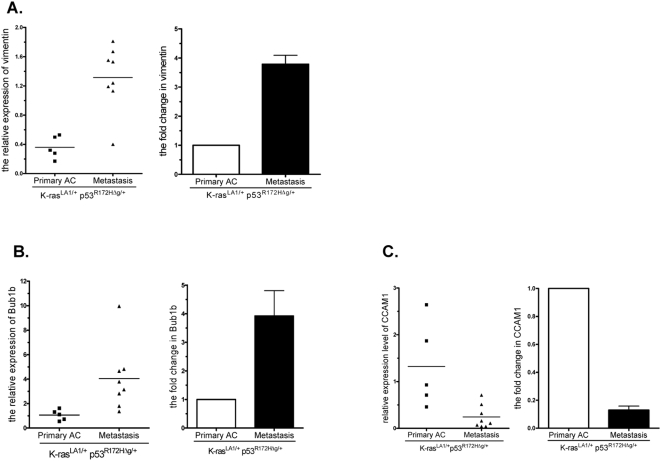
Verification of mRNA expression levels by Q-PCR.Total RNA from spontaneous tumors for gene expression profiling was reverse-transcribed with the First-Strand cDNA Synthesis Kit (Amersham Bioscience). Real-time PCR reactions were prepared in duplicate in a 96- or 384-well clear optical reaction plate (Applied Biosystems), using SybrGreen master mix (Applied Biosystems), and run on an ABI PRISM 7900HT Sequence Detection System (Applied Biosystems). Normal lung tissue from wild-type mice was used for calibration. Glyceraldhyde-3-phosphate dehydrogenase (GAPDH) was used as the endogenous control. The relative level of a gene was determined by calculating ΔΔCt, based on the formula ΔΔCt = (sample Ct [gene]−sample Ct [GAPDH])−(normal lung Ct [gene]−normal lung Ct [GAPDH]).